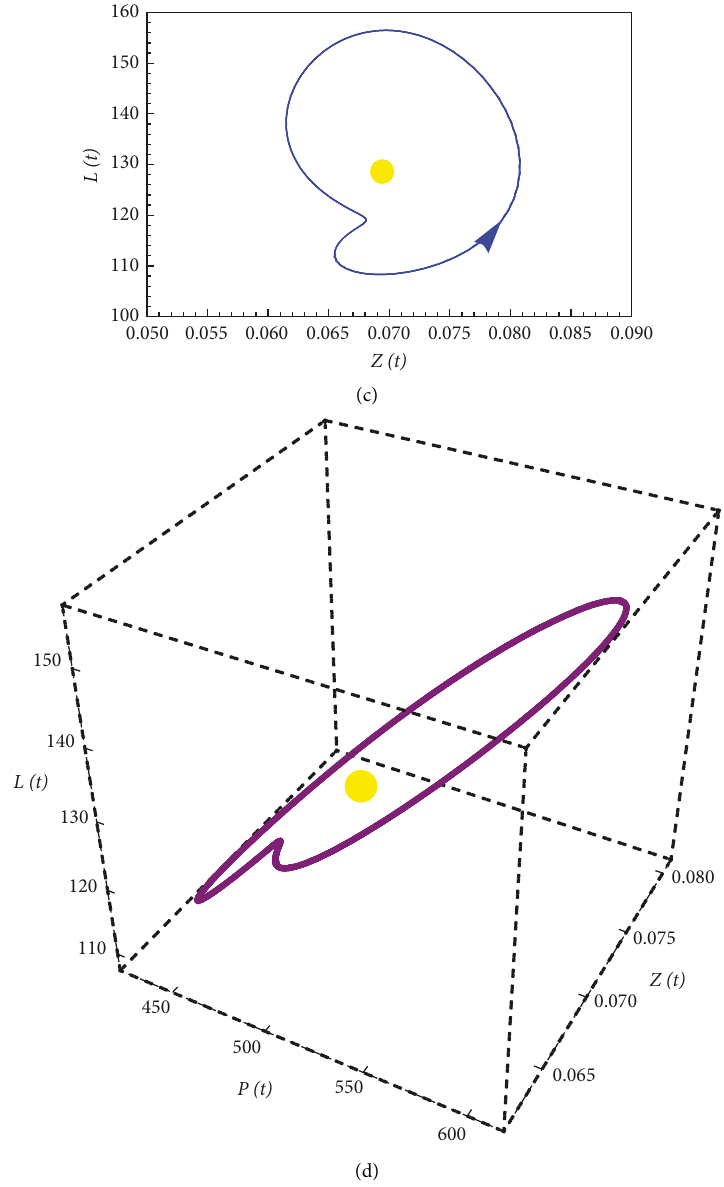
Figure 10: Phase portrait showing the dynamics of (a) phytoplankton and nutrients; (b) zooplankton and phytoplankton; (c) Limnothrissa miodon and zooplankton; (d) Limnothrissa miodon, zooplankton, and phytoplankton for model system (2) with assumed initial condition: N ( 0 ) � 10 ,P ( 0 ) � 7 ,Z ( 0 ) � 4 , L ( 0 ) � 2 using the default parameter